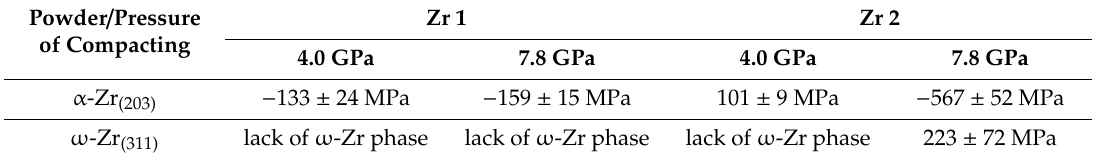
Table 6. The residual stresses in Zr 1 and Zr 2 high-pressure compacted powders.